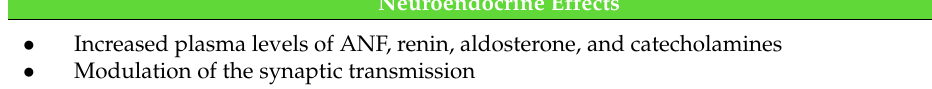
Table 5. Neuroendocrine Effects.